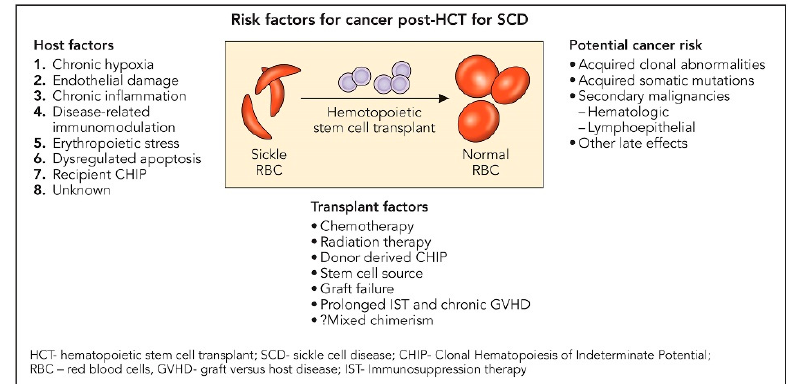
Figure 1. Risk factors for cancer post-transplantation for sickle cell disease.